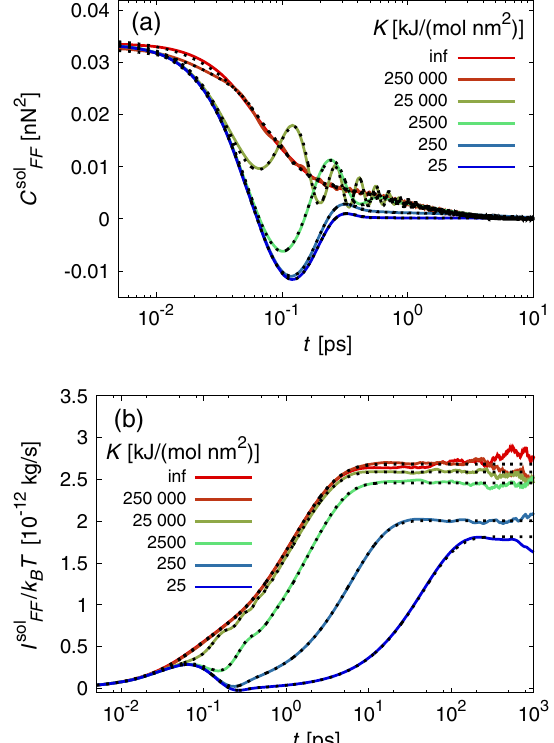
FIG. 2. Simulated solvent force autocorrelations for box size ð t Þ defined in L ¼ 4 . 5 nm. (a) Autocorrelation functions C sol FF ð t Þ defined in Eq. (6) for different Eq. (3) and (b) integrals I sol FF confinement potential strengths K . Colored lines denote simu- lation results, dotted lines are analytic predictions according to Eq. (4) using the best-fit memory function Γ ð t Þ